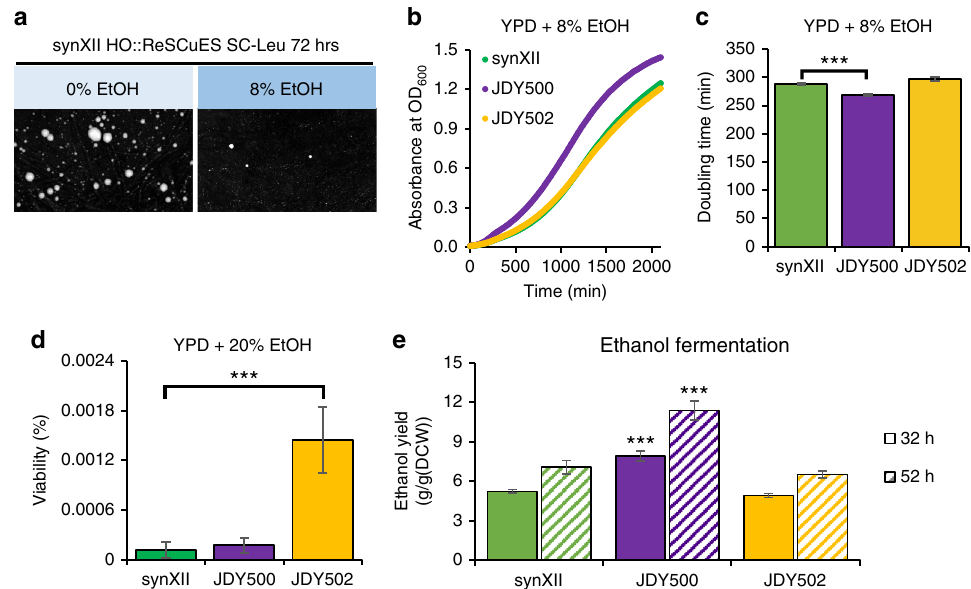
Fig. 3 Identify the SCRaMbLEd strains with increased ethanol tolerance. a Images of clones on SC-Leu plate with (8%) or without (0%) ethanol. The pictures were taken at 72 h after plating. b Growth curves of two ethanol-tolerant strains (JDY500 and JDY502) in YPD medium with 8% ethanol compared to that of the original synXII strain. The mean of three biological replicates of each strain was shown. c Doubling time (mean ± s.d.) of JDY500 and JDY502 in YPD medium with 8% ethanol compared to that of the original synXII strain. Three biological replicates were measured, *** is for a P -value < 0.01 using two-tailed student t -test. d Viability (mean ± s.d.) of JDY500 and JDY502 compared to that of the original synXII strain after treatment with 20% ethanol for 2 h. Three independent colonies of each strain were tested. *** is for a P -value < 0.01 using two-tailed student t -test. e Measurement of ethanol yields using static fermentation model. The ethanol yield (mean ± s.d.) was measured at 32 and 52 h after switching to the static cultures and presented as gram ethanol per gram dry cell weight (g g − 1 (DCW)). Three biological replicates were measured, *** is for a P -value < 0.01 using